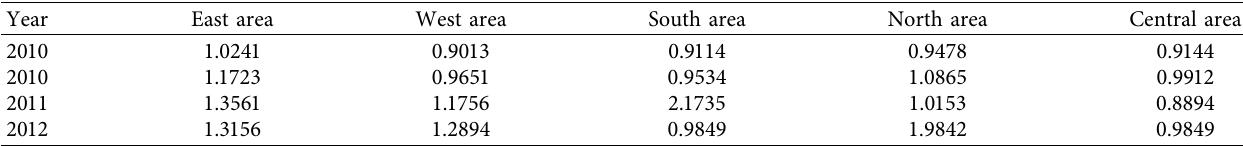
Table 5: Malmquist productivity indices of